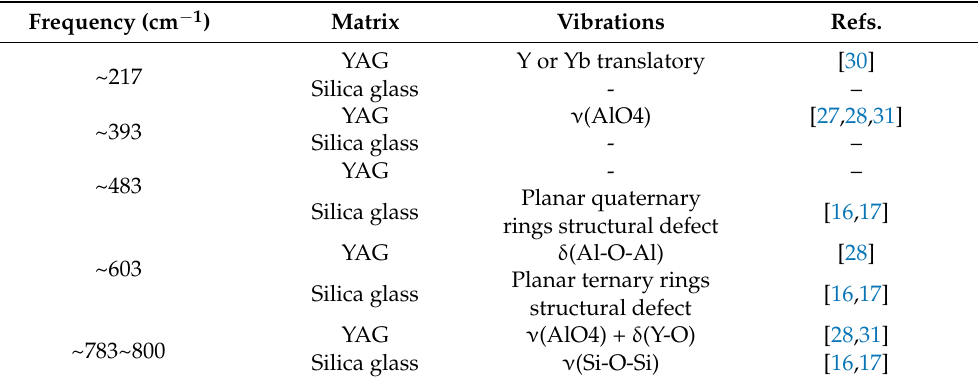
Table 2. Structural vibrations in Raman spectra of silica glass and YAG